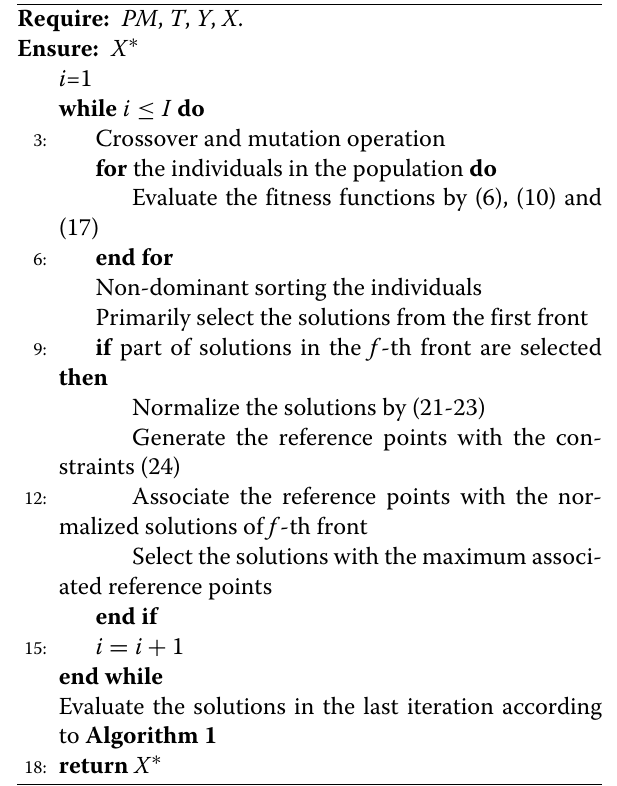
Algorithm 2 Data Placement method in